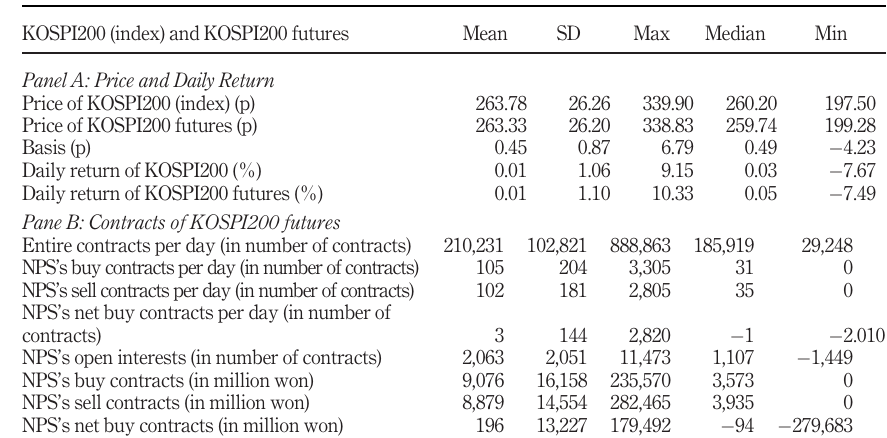
KOSPI200 (index) and KOSPI200 futures Mean SD Max Median Panel A: Price and Daily Return Price of